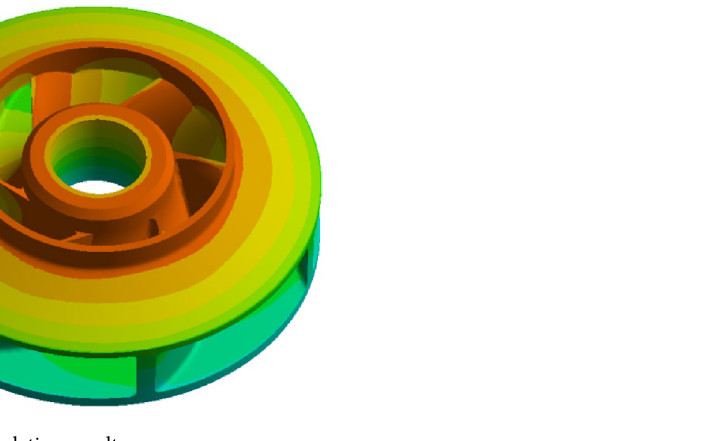
Figure 10. Simulation calculation